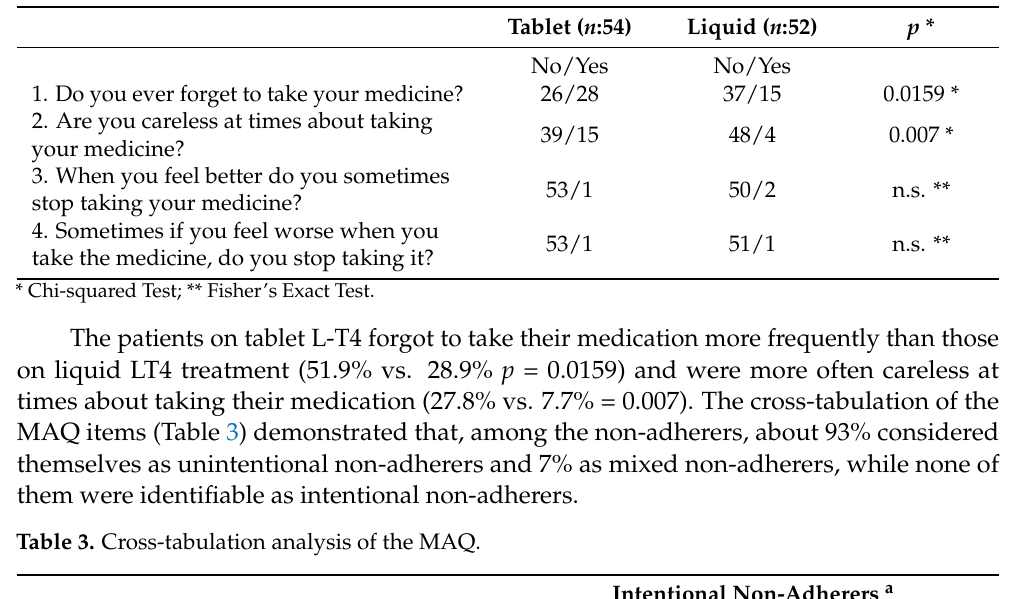
Table 2. The four-item MAQ.